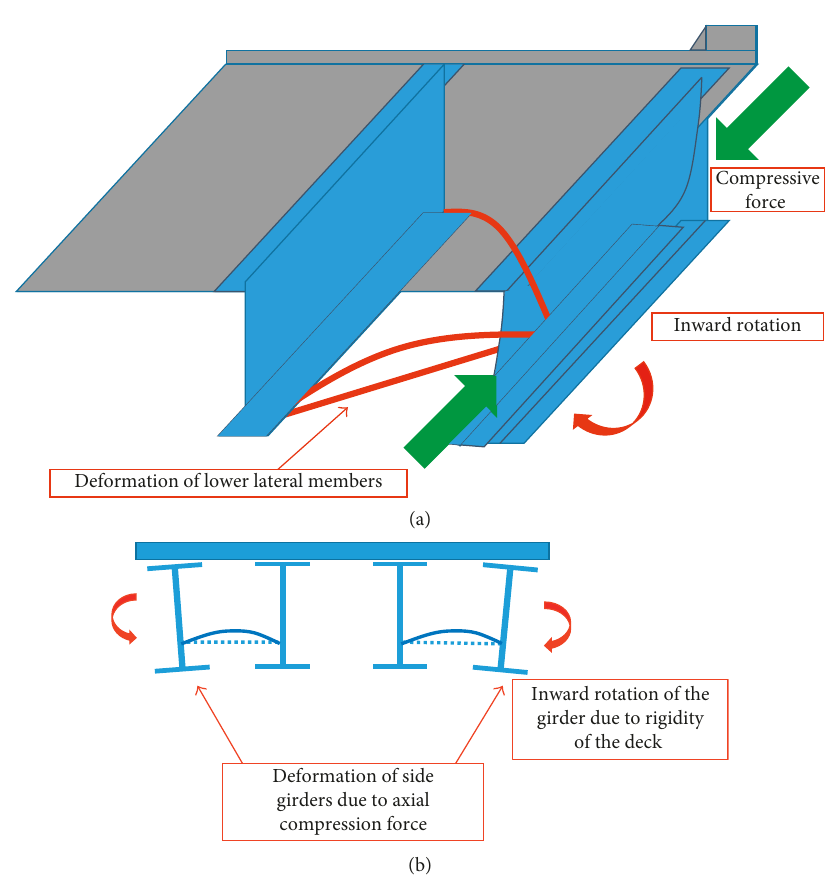
Figure 23: Deformation mechanism of the main girder and lower lateral